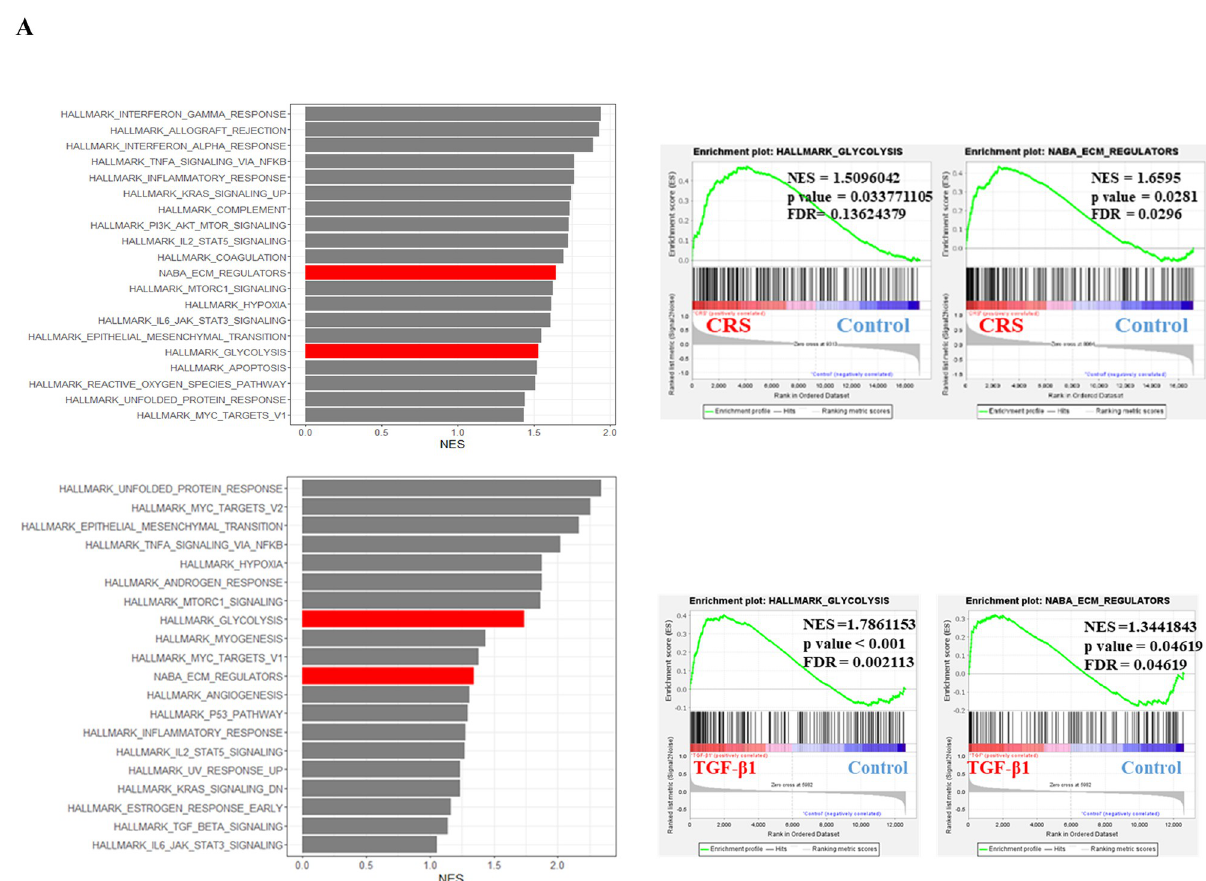
Fig 5. Gene set enrichment analysis (GSEA) were analyzed using transcripts of chronic rhinosinusitis (CRS) patients and TGF- β 1-treated nasal fibroblast. (a) Normalized enrichment scores (NES) of the top 20 positively enriched gene sets, red is glycolysis and ECM REGULATORS gene sets in CRS patients. NES, p-value and false discovery rate (FDR) of glycolysis gene set and ECM REGULATORS gene set in CRS patients. NES of the top 20 positively enriched gene sets in TGF- β 1-treated nasal fibroblast. NES, p-value and FDR of glycolysis gene set and ECM REGULATORS gene set in TGF- β 1-treated nasal